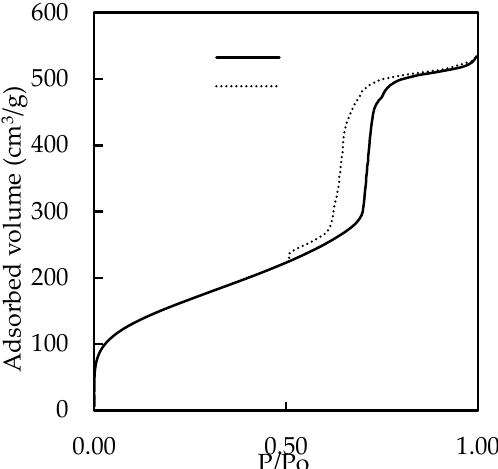
Figure 5. N 2 adsorption / desorption isotherm plots for the Py-PMO material obtained at the liquid nitrogen temperature.